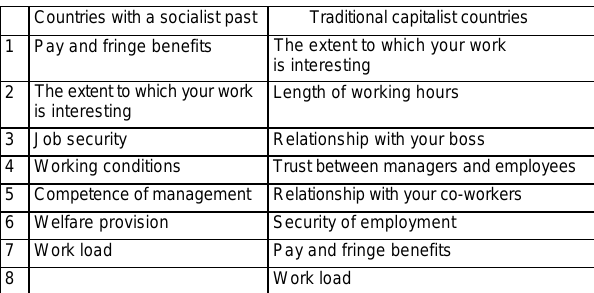
Table 2. Facets contributing to general job